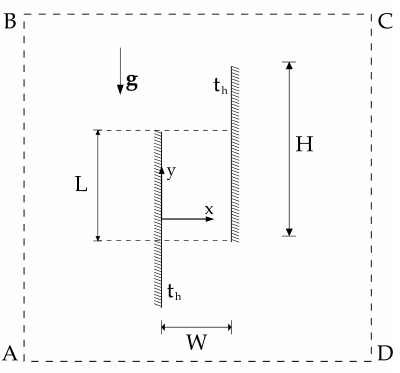
Figure 1. Sketch of the geometry, coordinate system and computational